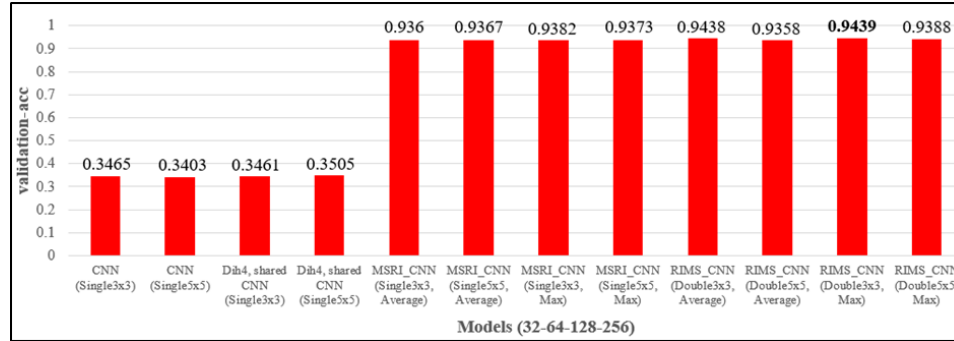
Figure 12. The results of different designs validated on the fixed-angle-rotated MNIST.